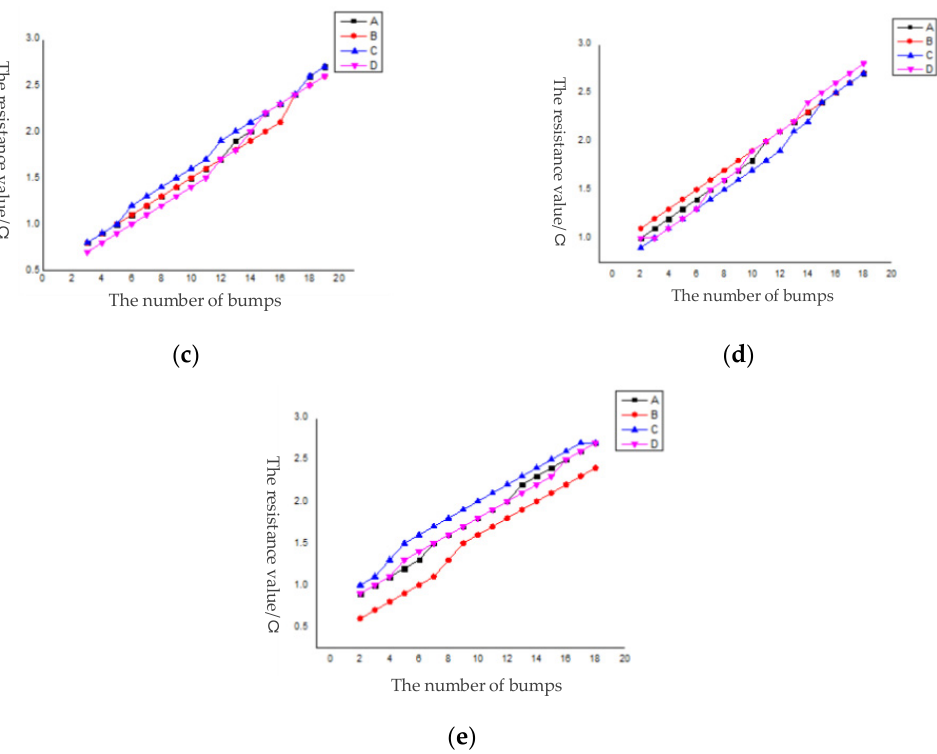
Figure 14. Resistance curve of daisy chain in each region. ( a ) die in Region 1; ( b ) die in Region 2; ( c ) die in Region 3; ( d ) die in Region 4; ( e ) die in Region 5.